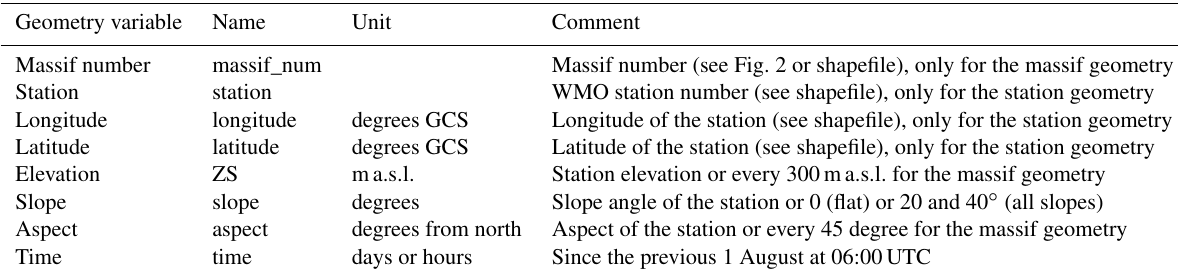
Table 2. Description of the metadata of the S2M dataset. Geometry variable